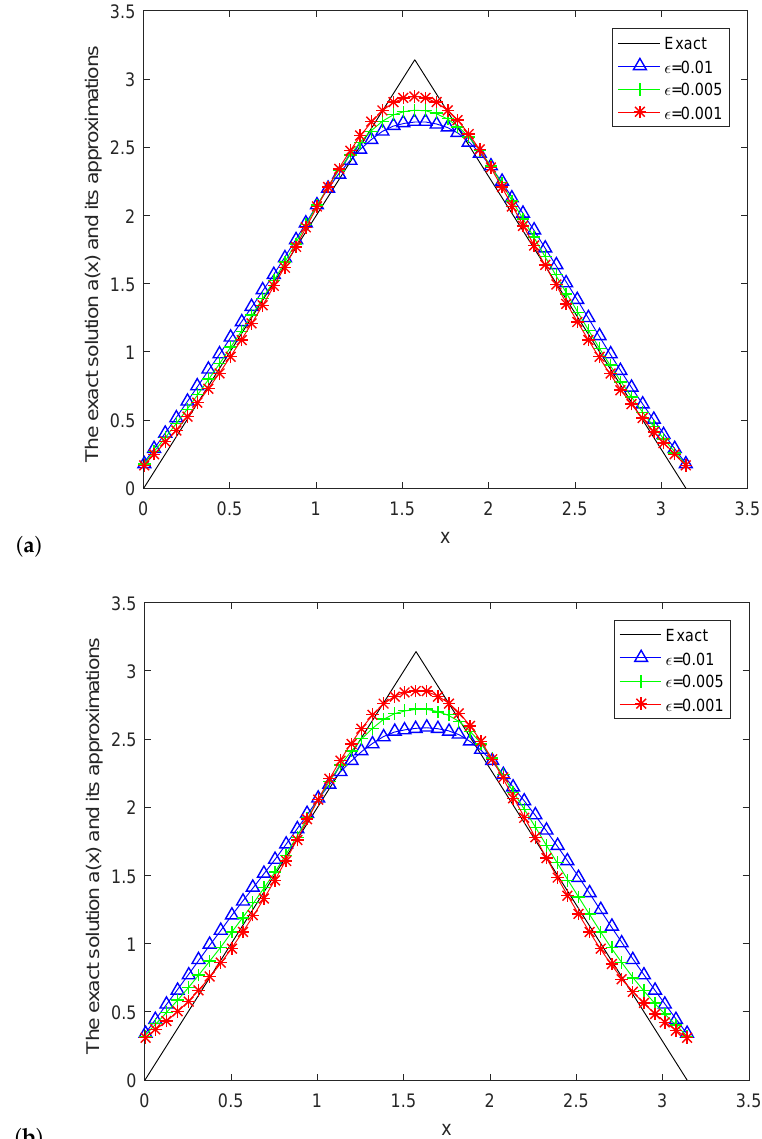
( x ) for Instance 2: ( a ) α = 1.2, ( b ) N 1